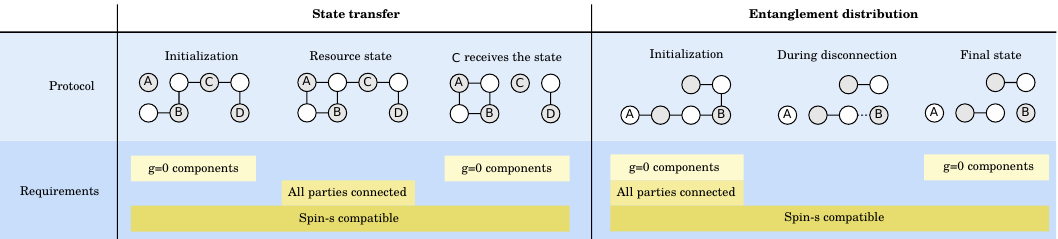
Figure 3: Example of a state transfer and entanglement distribution protocol, where we assume each site holds a particle with spin s . For readability, we label parties p with capital letters. On the left, A initializes the system into a resource state i encoding its original spin state, which is later obtained at C. On the right, the system is initialized in a global singlet, after which A and B disconnect to obtain singlet entanglement between their sites. At various stages in these protocols, the network must obey requirements such as (from top to bottom) all connected components except for the disconnected parties have g = 0, all parties must be connected, and throughout the whole protocol, the graph must remain spin- s